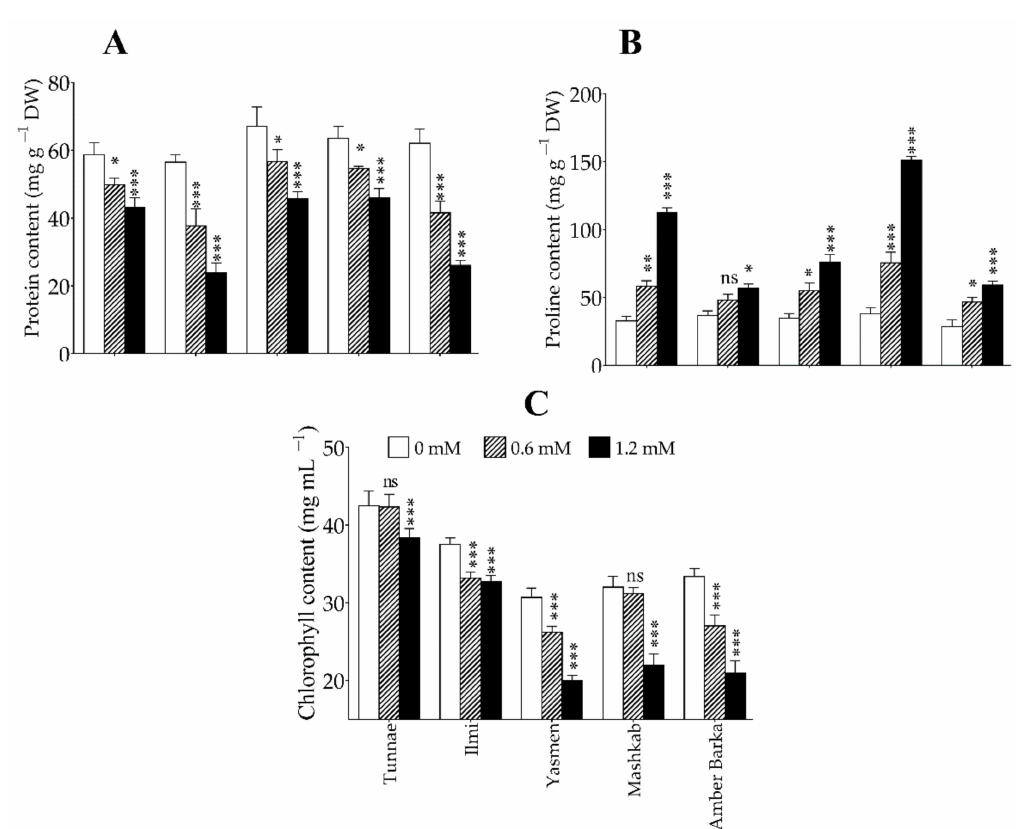
Figure 5. Changes in the chlorophyll content under lead treatment. ( A ) Protein content, ( B ) proline content, and ( C ) total chlorophyll content in Tunnae, Ilmi, Yasmen, Mashkab, and Amber Barka in response to gradient lead (Pb) concentrations. Bars are mean values ± SE. White bars are controls (plant grown without Pb treatment), striped bars and black bars are plants treated with 0.6 and 1.2 mM Pb, respectively. The above figure shows the changes in total chlorophyll content in response to different lead (Pb) concentrations (0.6 and 1.2 mM) in five rice cultivars (Tunnae, Ilmi, Yasmen, Mashkab, and Amber Barka). Bars are mean values ± SE. *** p < 0.001, ** p < 0.01, * p < 0.05, ns :